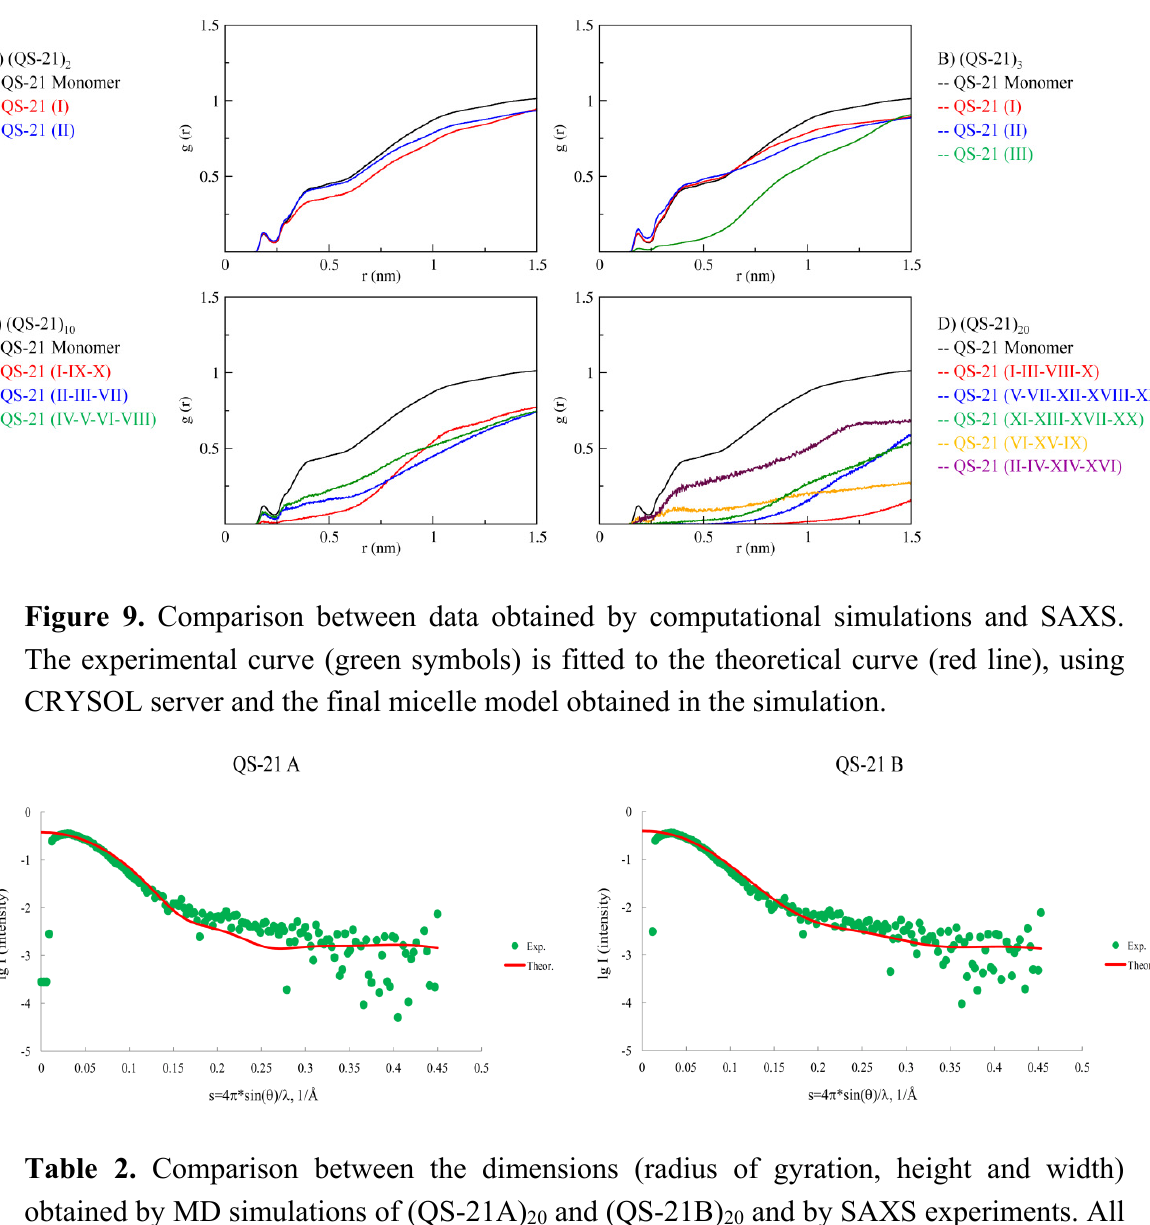
and (QS-21B) and by SAXS experiments. All 20 20